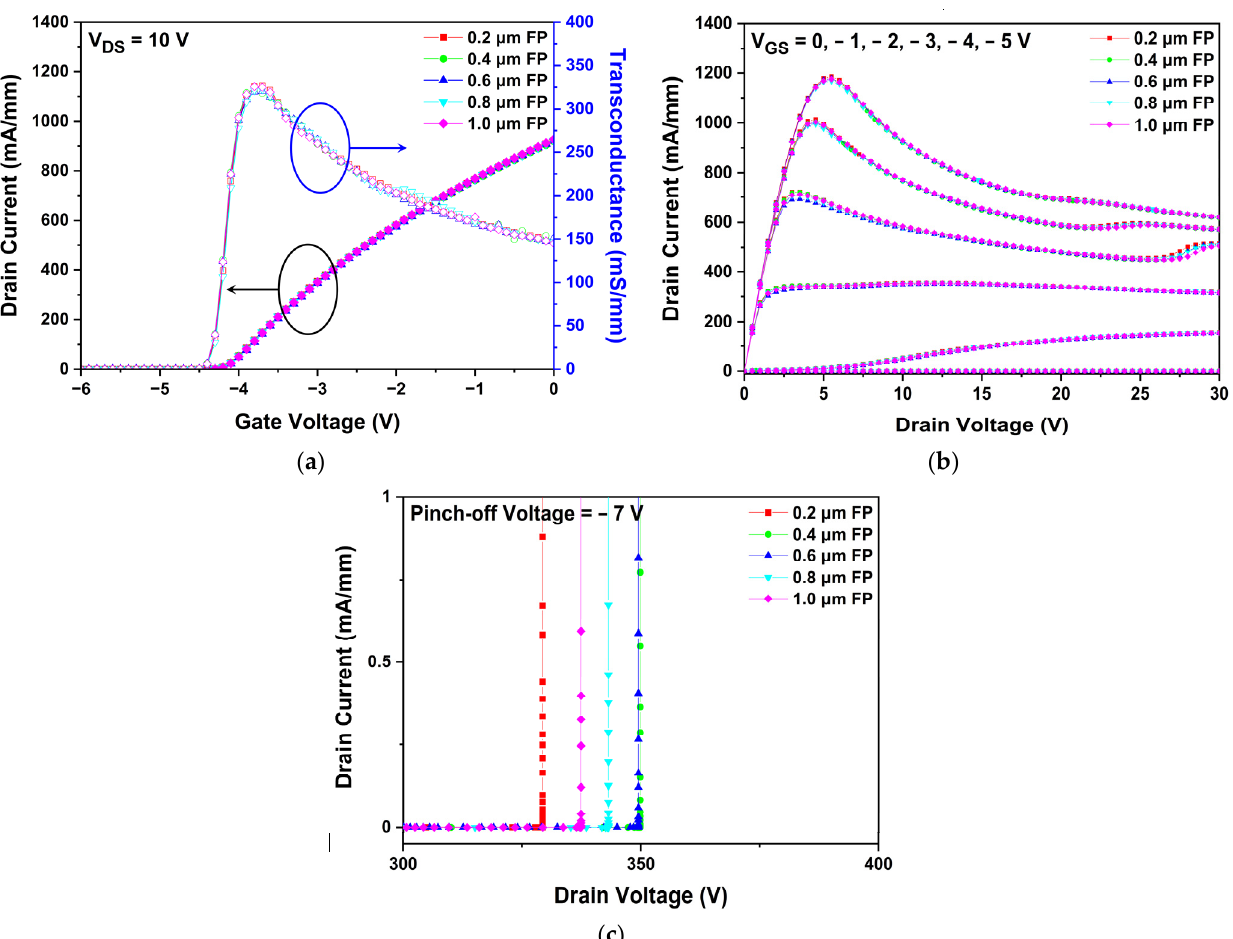
Figure 12. Simulated results of the DC characteristics of slant C structure with various FP lengths: ( a ) I DS -V GS transfer characteristics at V DS = 10 V; ( b ) I DS -V DS transfer characteristics at gate voltages of –5, –4, –3, –2, –1, and 0 V; and ( c ) breakdown characteristics at a pinch-off of V (cid:2891)(cid:2903) = –7 V.